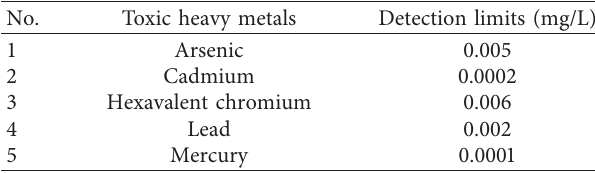
Table 1: Detection limits of the toxic heavy metals.